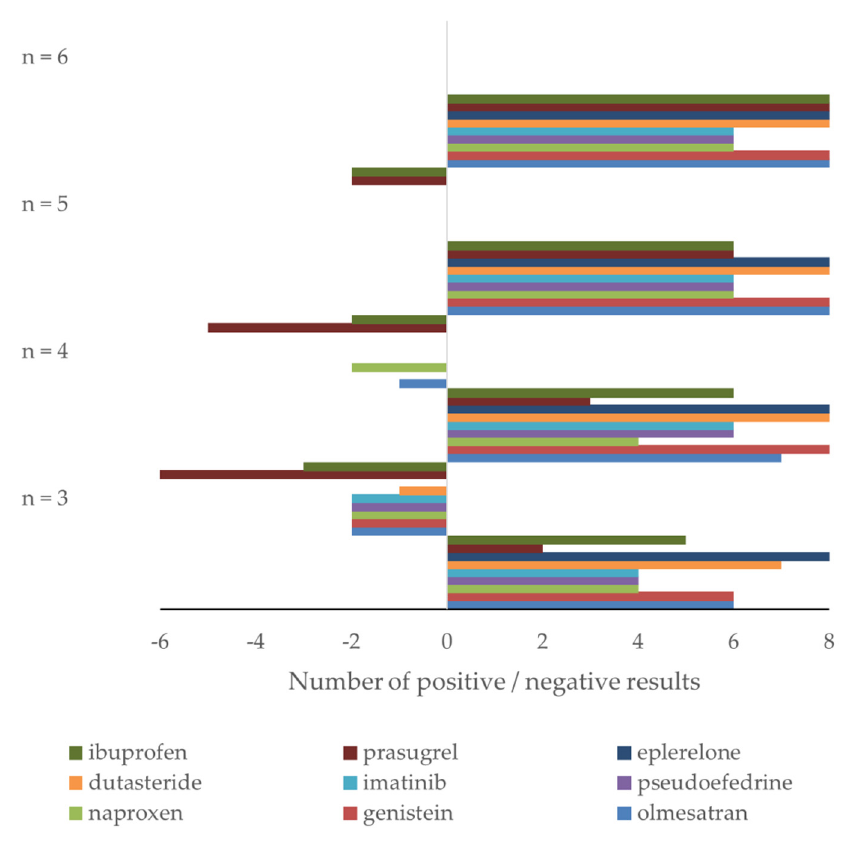
Figure 5. Retrospective study of nine drugs’ stability in human plasma: number of confidence intervals within (positive results) and outside (negative results) acceptance criteria for nine drugs using n = 3, 4, 5, and 6 samples for stability testing. High and low concentration data are combined.